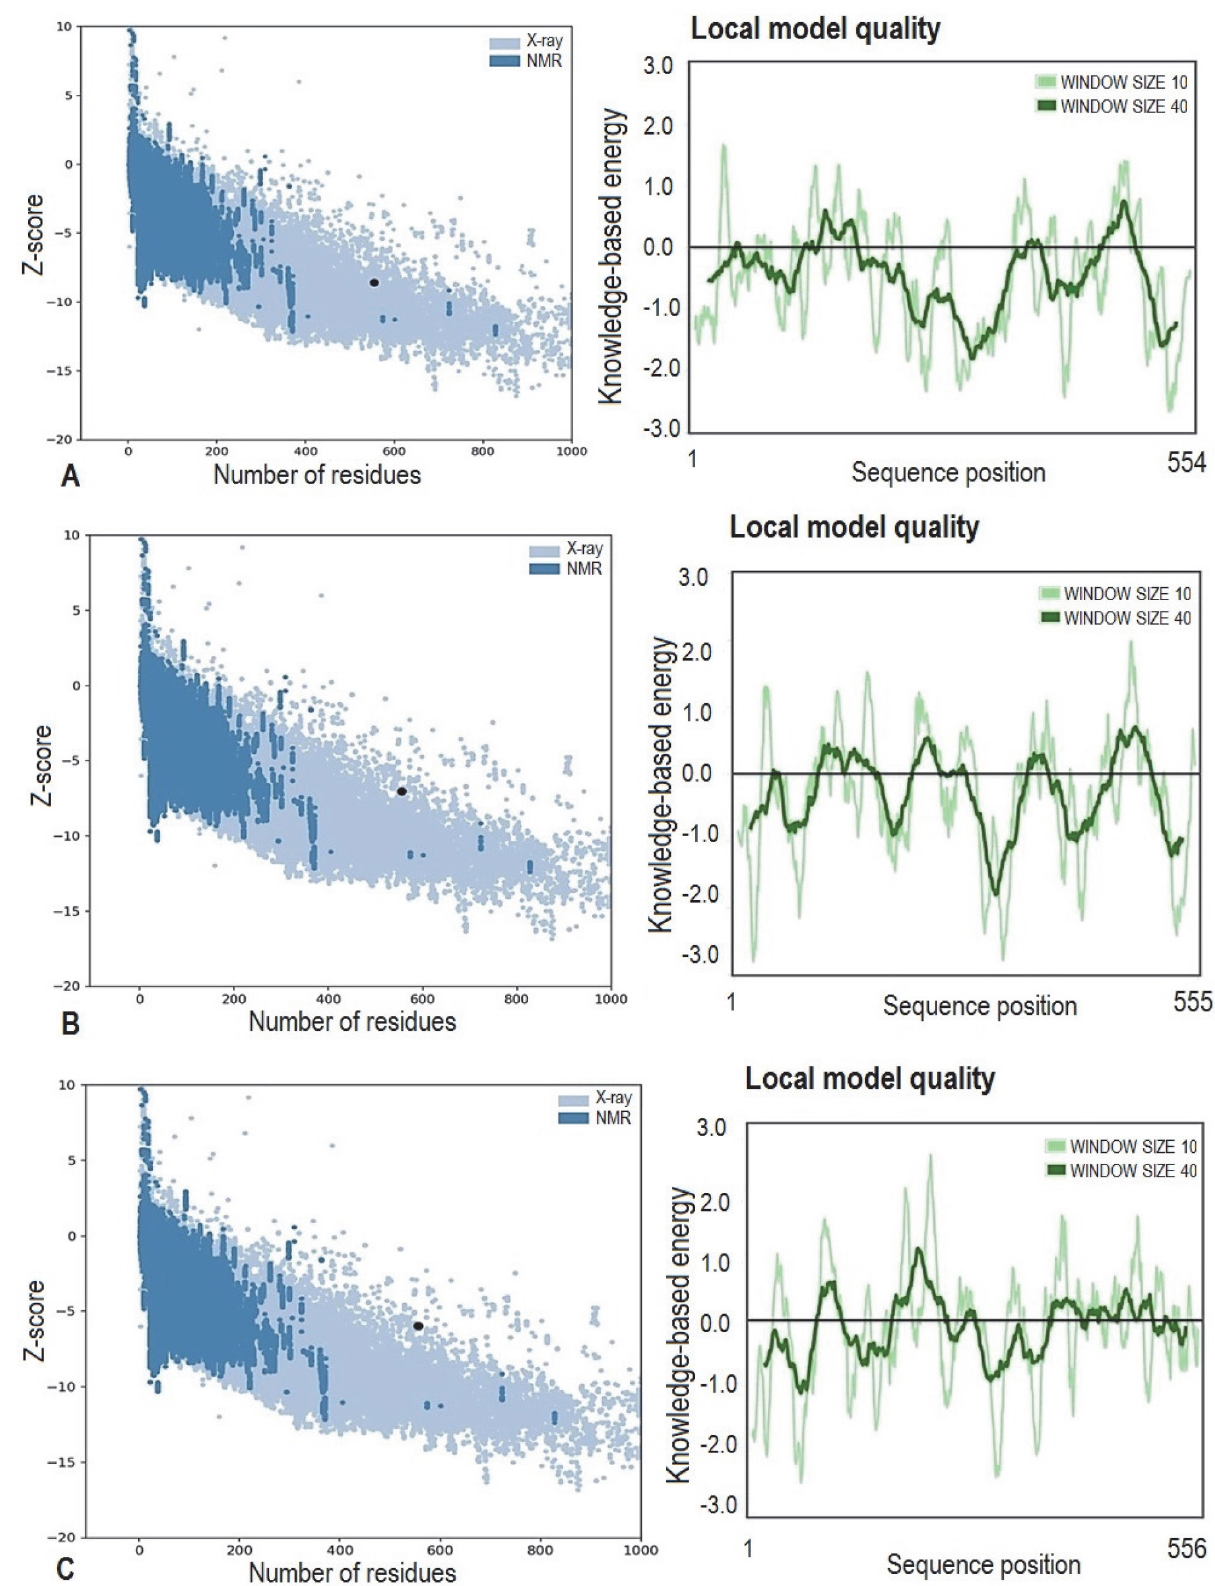
Figure 6. ProSA-web service analysis of human OCT1-3 proteins. The black points represent that model hOCT1-3 proteins are in the range of Z-score values of the experimental structures according to several residues. The other graph shows the local quality concerning many sequence po- sitions (A; OCT-1, B; OCT-2, C; OCT-3). respectively (Z-score:–8.59, –7.04,